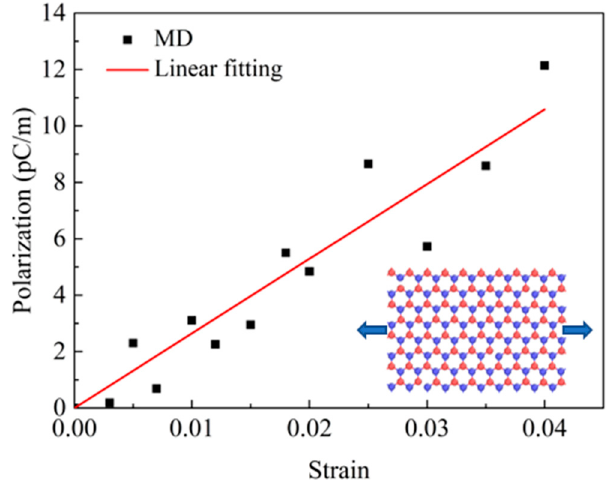
Figure 9. The polarization-strain curves of BN nanosheet under tensile loading along the zigzag direction obtained from molecular dynamics (MD) simulations.